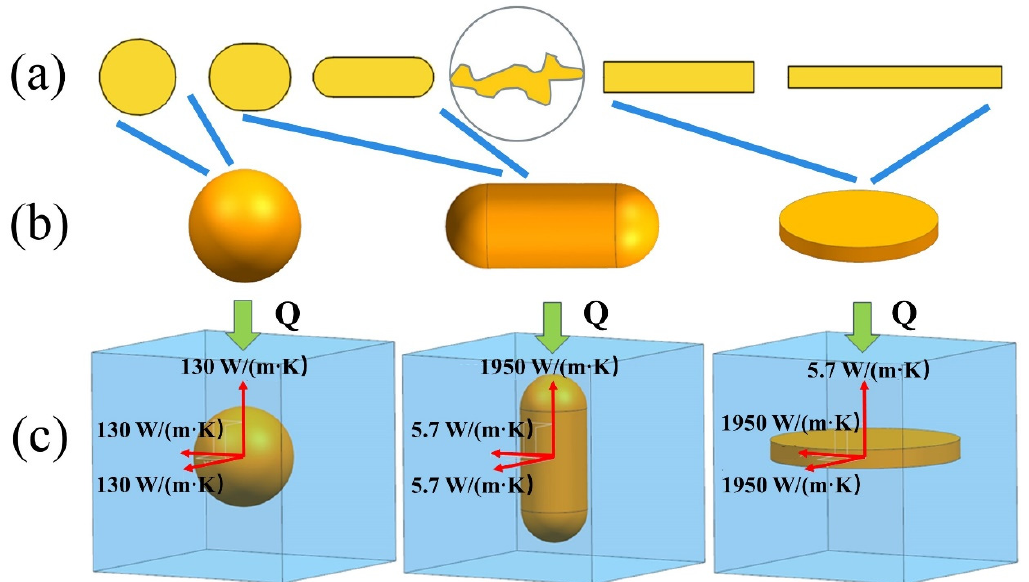
Figure 1. Establishment of a series of unit cell models by shape interpolation. ( a ) Two-dimensional abstractions of typical structures in metallographic photographs. ( b ) Three-dimensional abstractions of typical structures in metallographic photographs. ( c ) Demonstrations about method to calculate equivalent thermal conductivity (one of all directions) of three-dimensional abstractive models.